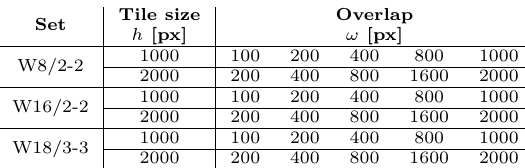
Table 1. Preview of used combinations of settings.